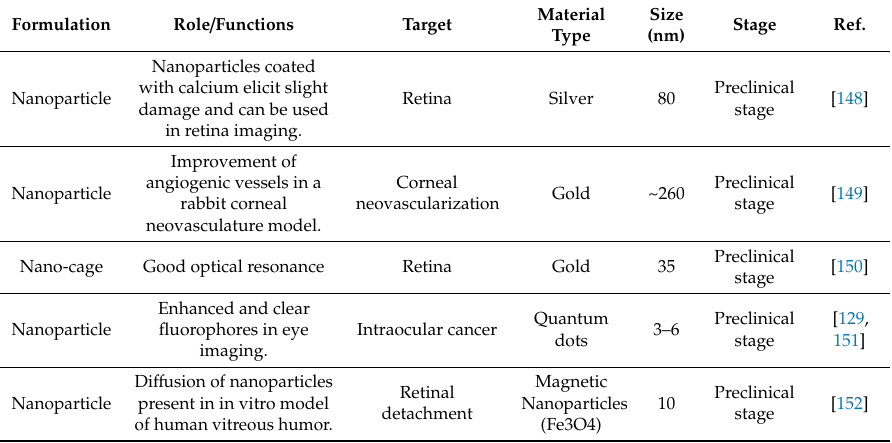
Table 3. Prospective nanotechnology-based approaches for glaucoma